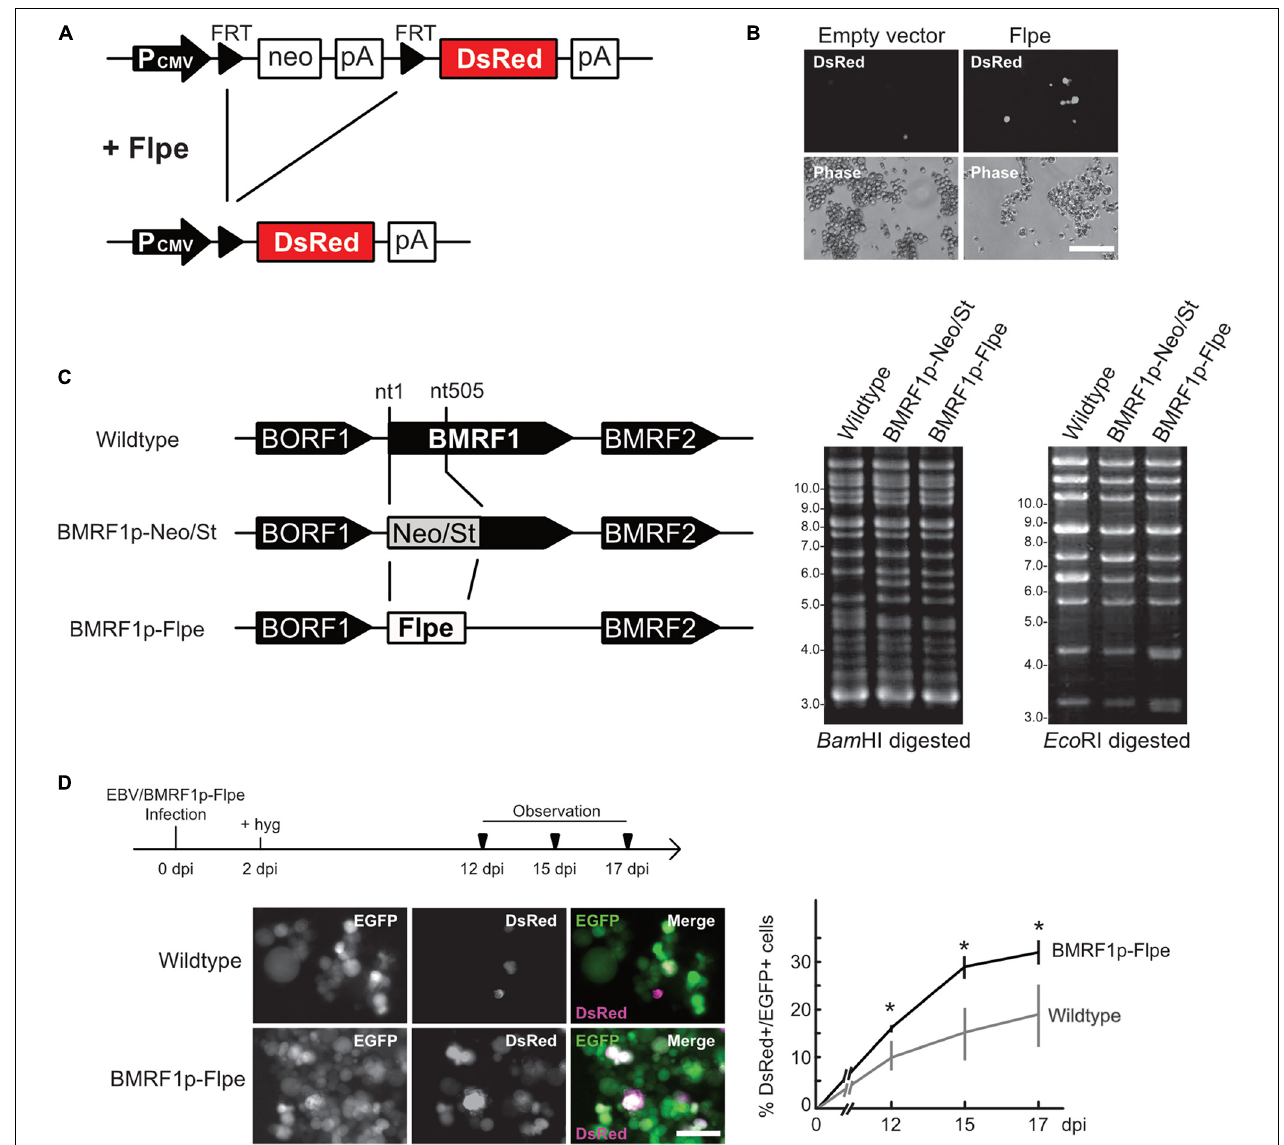
FIGURE 6 | EBV establishes latency in B-cells via an abortive lytic infection in the pre-latent phase. (A) Schematic representation of the genetic elements in the Flpe-FRT system. Flpe recombinase can recombine FRT sites in the ubiquitously expressed reporter construct to remove the STOP (neomycin resistant gene and polyA signal; neo-pA) cassette. Upon removal of this STOP, the reporter DsRed is expressed in the cells and all their progeny. (B) DsRed was expressed in the presence of Flpe. Akata/FNF-DsRed reporter cells were transfected with a Flpe expression plasmid. Scale bar, 100 µ m. (C) Schematic diagram of recombinant EBV (EBV/BMRF1p-Flpe) construction. The Neo/St cassette, containing neomycin resistance and streptomycin sensitivity genes, was inserted between nucleotides 1 and 505 of the BMRF1 gene to prepare an intermediate, and this was replaced with the Flpe sequence to construct the EBV/BMRF1p-Flpe, which expresses Flpe under the control of the BMRF1 promoter ( left ). Successful recombination was confirmed by the electrophoresis of the EBV-BAC after Bam HI and Eco RI digestion ( righ t). (D) Continuous tracing of abortive lytic cells with recombinant EBV. Akata/FNF-DsRed cells were infected with EBV/BMRF1p-Flpe. Two days after infection, hygromycin was added to the medium to select infected cells. Infected cells were continuously observed (arrowheads) until 17 dpi. The number of DsRed-positive and EGFP-positive cells was counted at indicated time points. Results shown are the means ± SD of three independent experiments. Images were obtained at 17 dpi. Asterisk (*) indicates p < 0.05; dpi, days post-infection. Scale bar, 50 µ m.